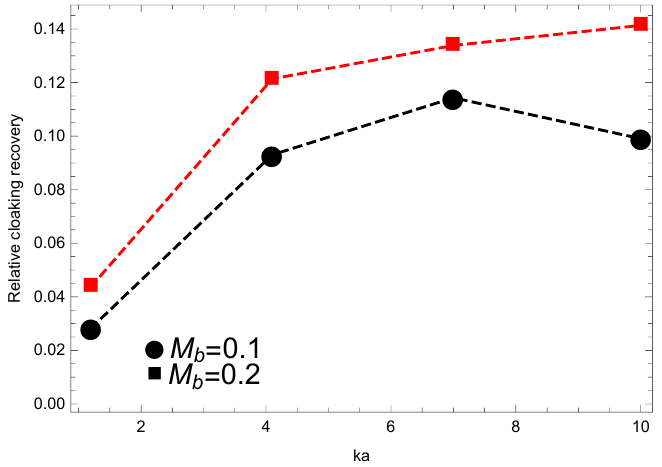
Figure 10. Directivity pattern at r = 5 R 2 of the insertion loss I M b = 0.0,0.1,0.2.